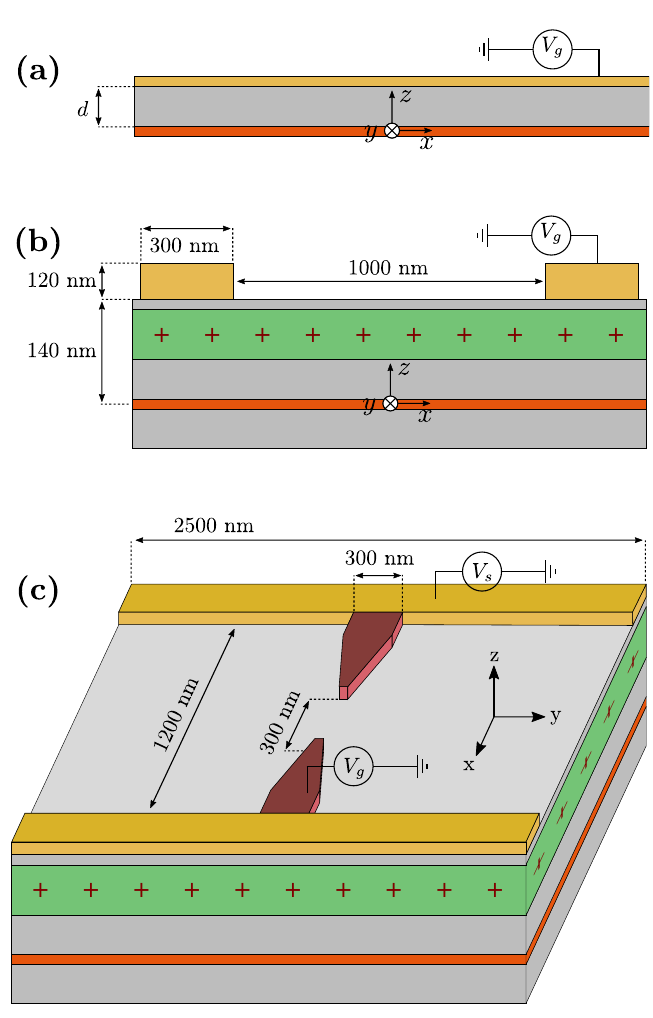
Figure 1: Schematics of the three systems considered in this article. (a) Infinite 2DEG along x and y directions. (b) Quasi-one dimensional wire infinite along the y direction. (c) Quantum Point Contact geometry. The red part corresponds to the 10 nm thick 2DEG. The green part corresponds to the doping region. The yellow and dark red part correspond to the electrostatic gates. The gray part corresponds to effective dielectrics (here GaAs and